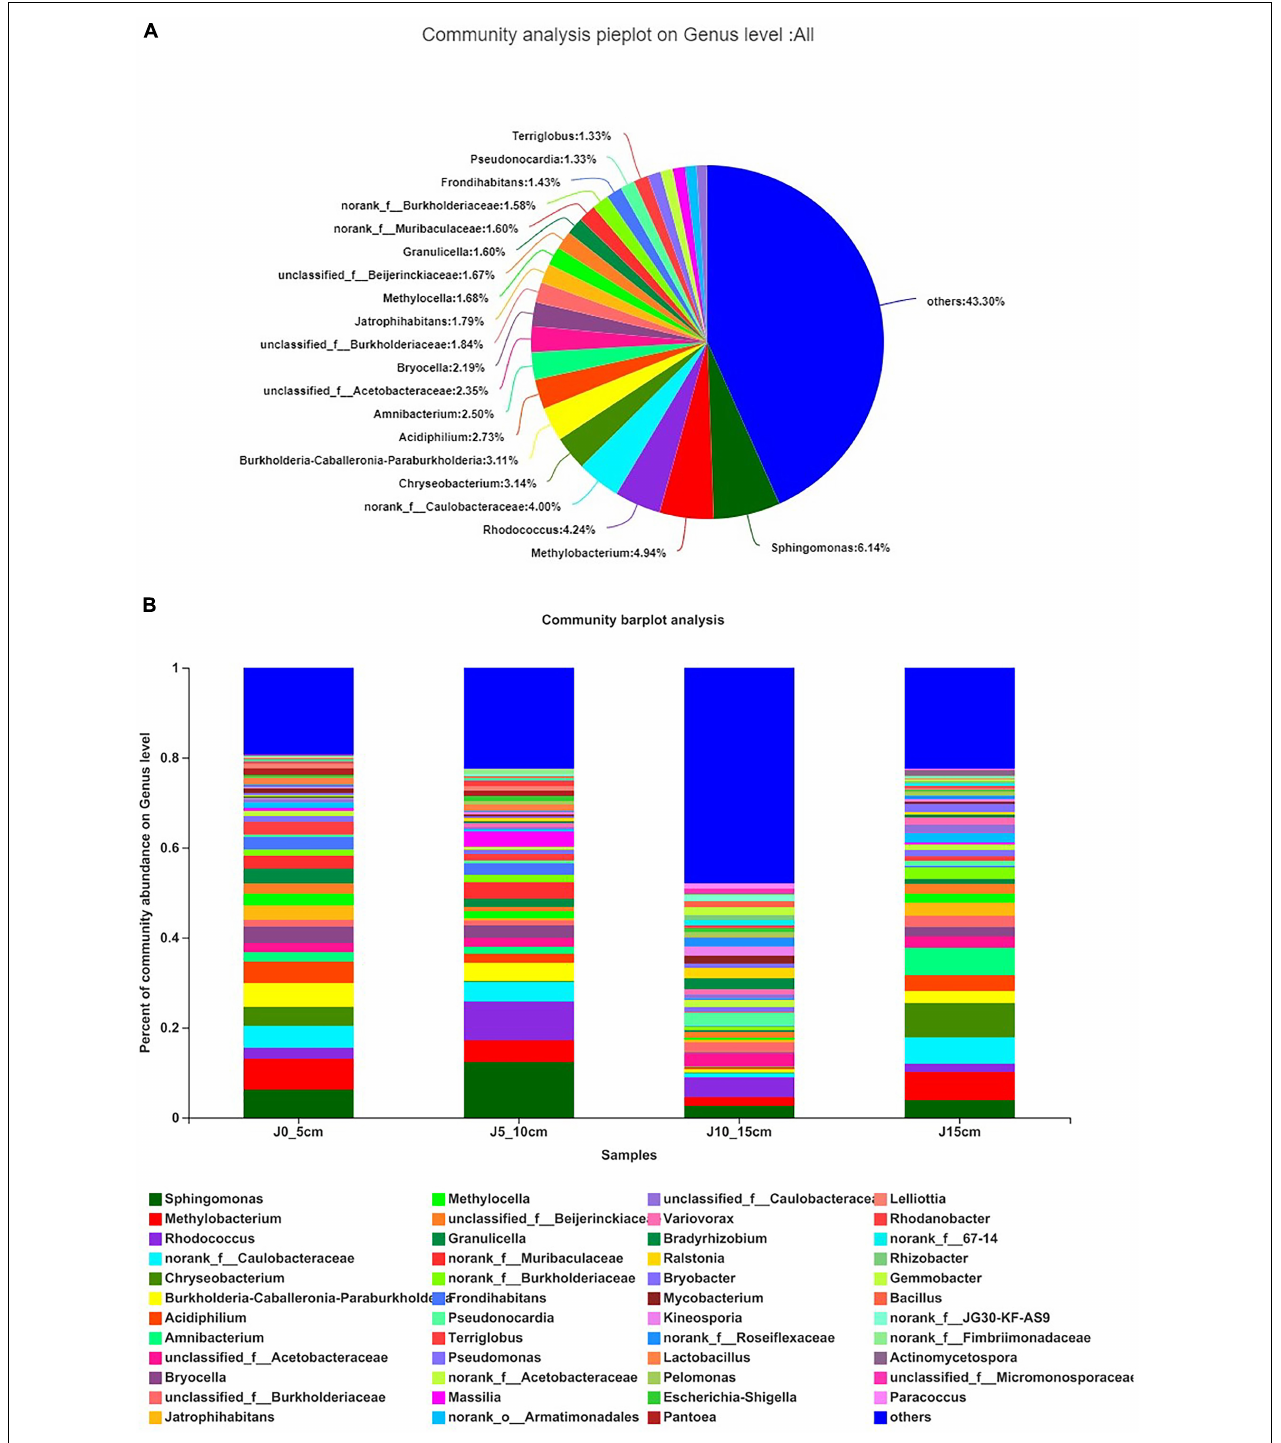
FIGURE 4 | Composition and relative abundance of endophytic bacterial on genus level. (A) Community analysis pieplot on genus level of culture-independent endophytic bacteria on whole. (B) Composition and relative abundance of endophytic bacterial in different samples on genus level. Color of column represents different genera, and length of column represents proportion size of genus. Sequences that could not be classified into any known group were assigned as “unclassified.” Genera making up less than 1% of total composition in each sample were classified as “other” (group J0_5cm represents length of stems was from 0 to 5 cm; group J5_10cm represents length of stems was from 5 to 10 cm; group J10_15cm represents length of stems was from 10 to 15 cm; group J15cm represents length of stems was longer than 15 cm).